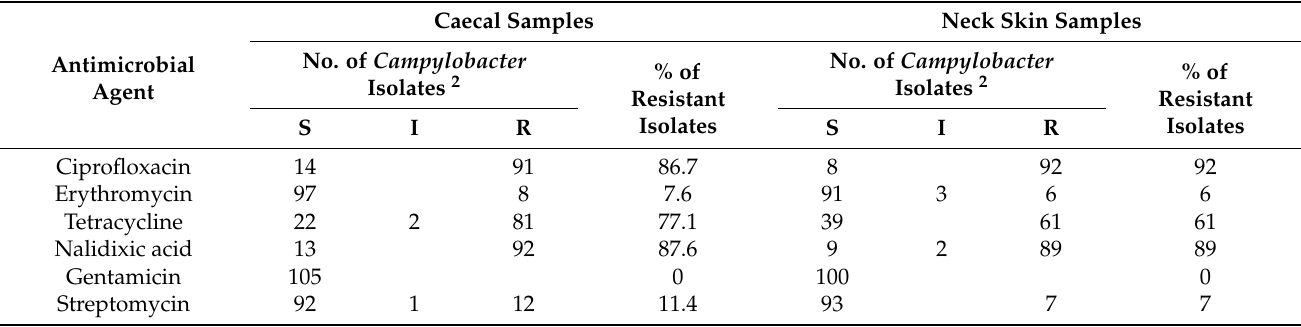
Table 2. Antimicrobial susceptibility patterns of Campylobacter spp., identified by the disk diffusion method, according to the sample tested 1 .